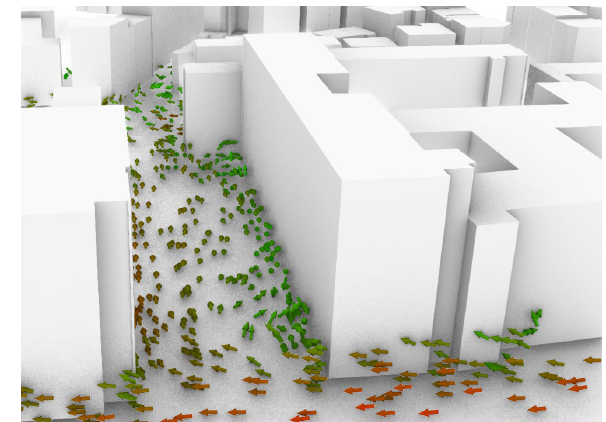
Figure 8. Wind velocity depicted with